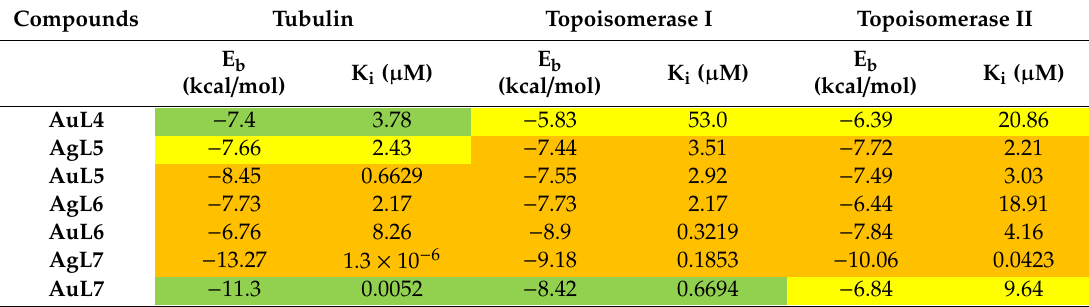
Table 2. Binding Energies and Binding constants for each compound tested in silico towards human topoisomerases I and II and